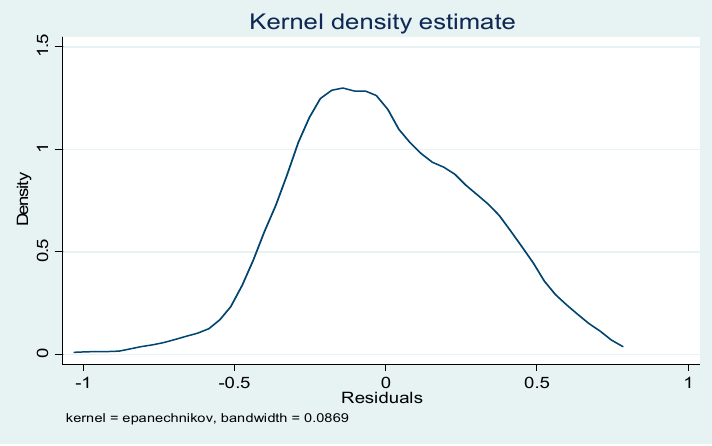
Figure 2. Kernel density estimation of residuals.